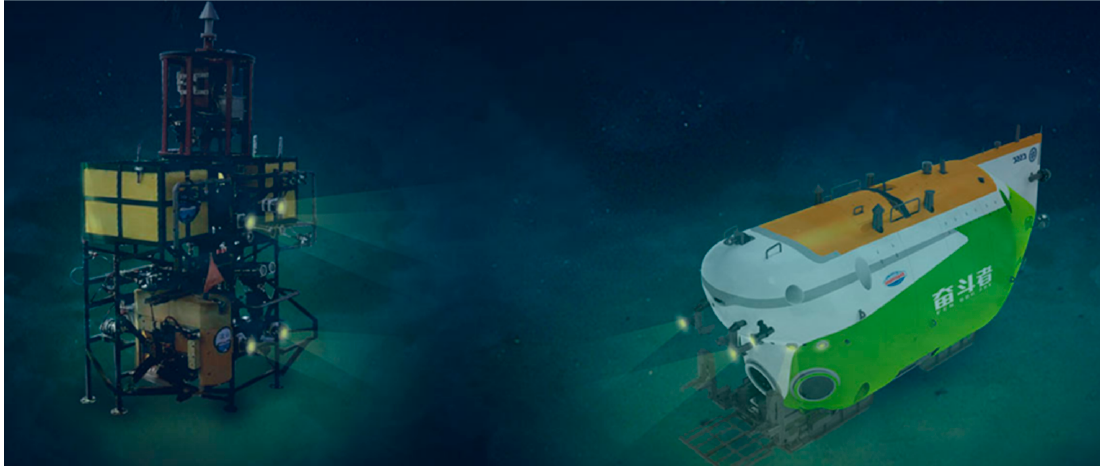
Figure 3. Cooperative operation of Canghai Lander and Fendouzhe HOV. The Chinese characters on HOV is Fendouzhe, which is the name of HOV.